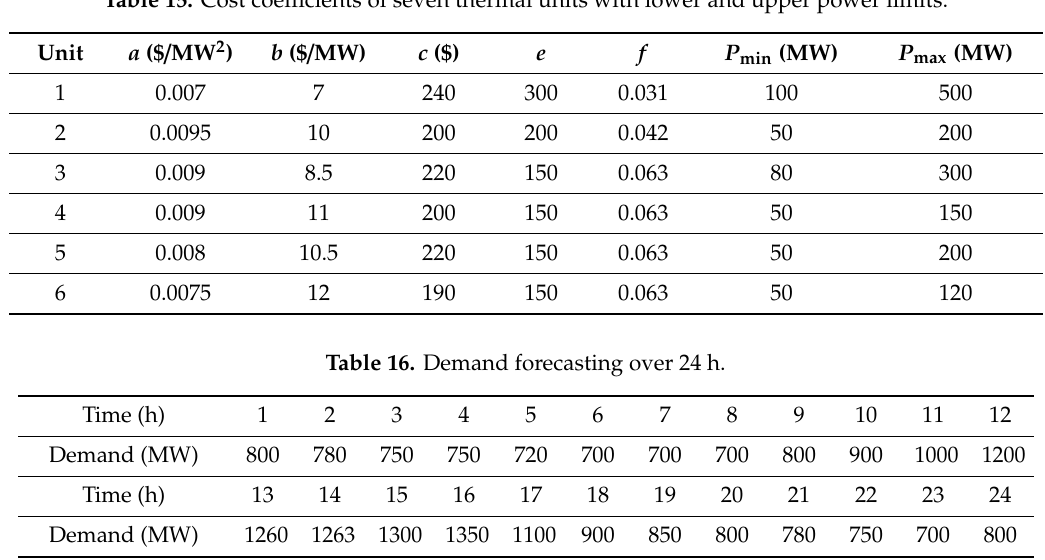
Table 15. Cost coe ffi cients of seven thermal units with lower and upper power limits.